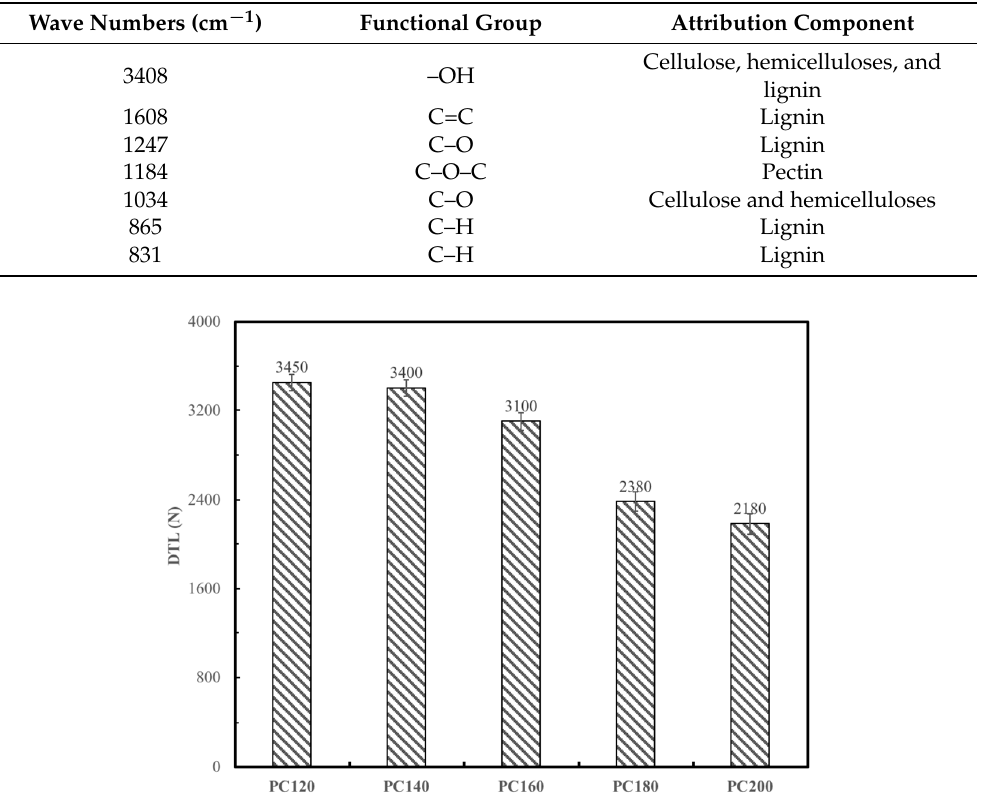
Figure 6. The damage threshold load (DTL) of FFRP laminates manufactured with different post curing temperatures.